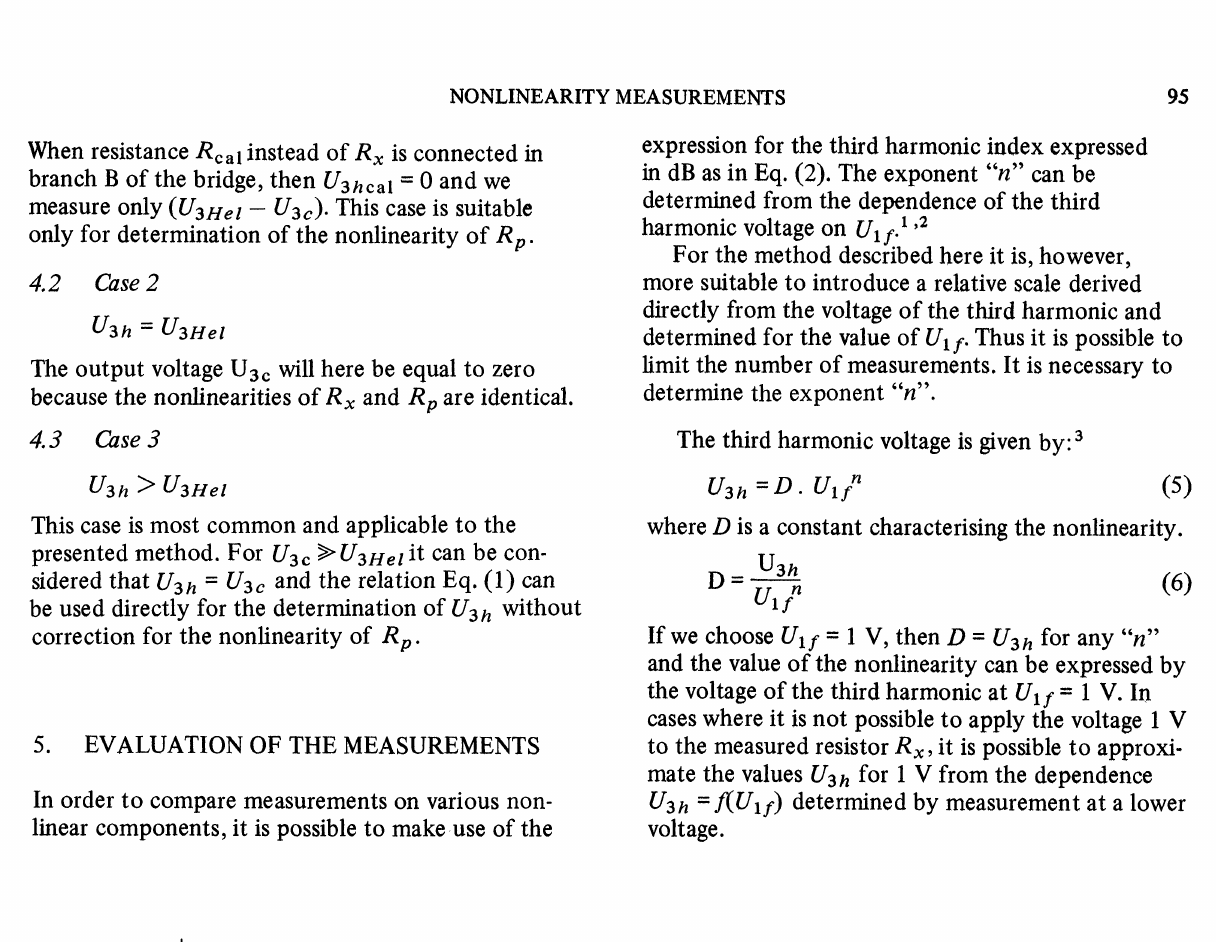
Dependence of the current noise on the third harmonic